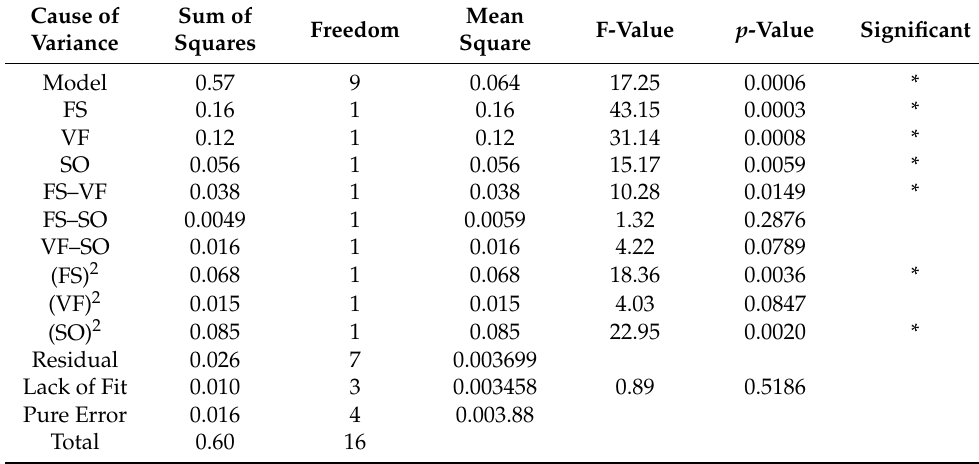
Table 9. ANOVA of the impurity ratio.